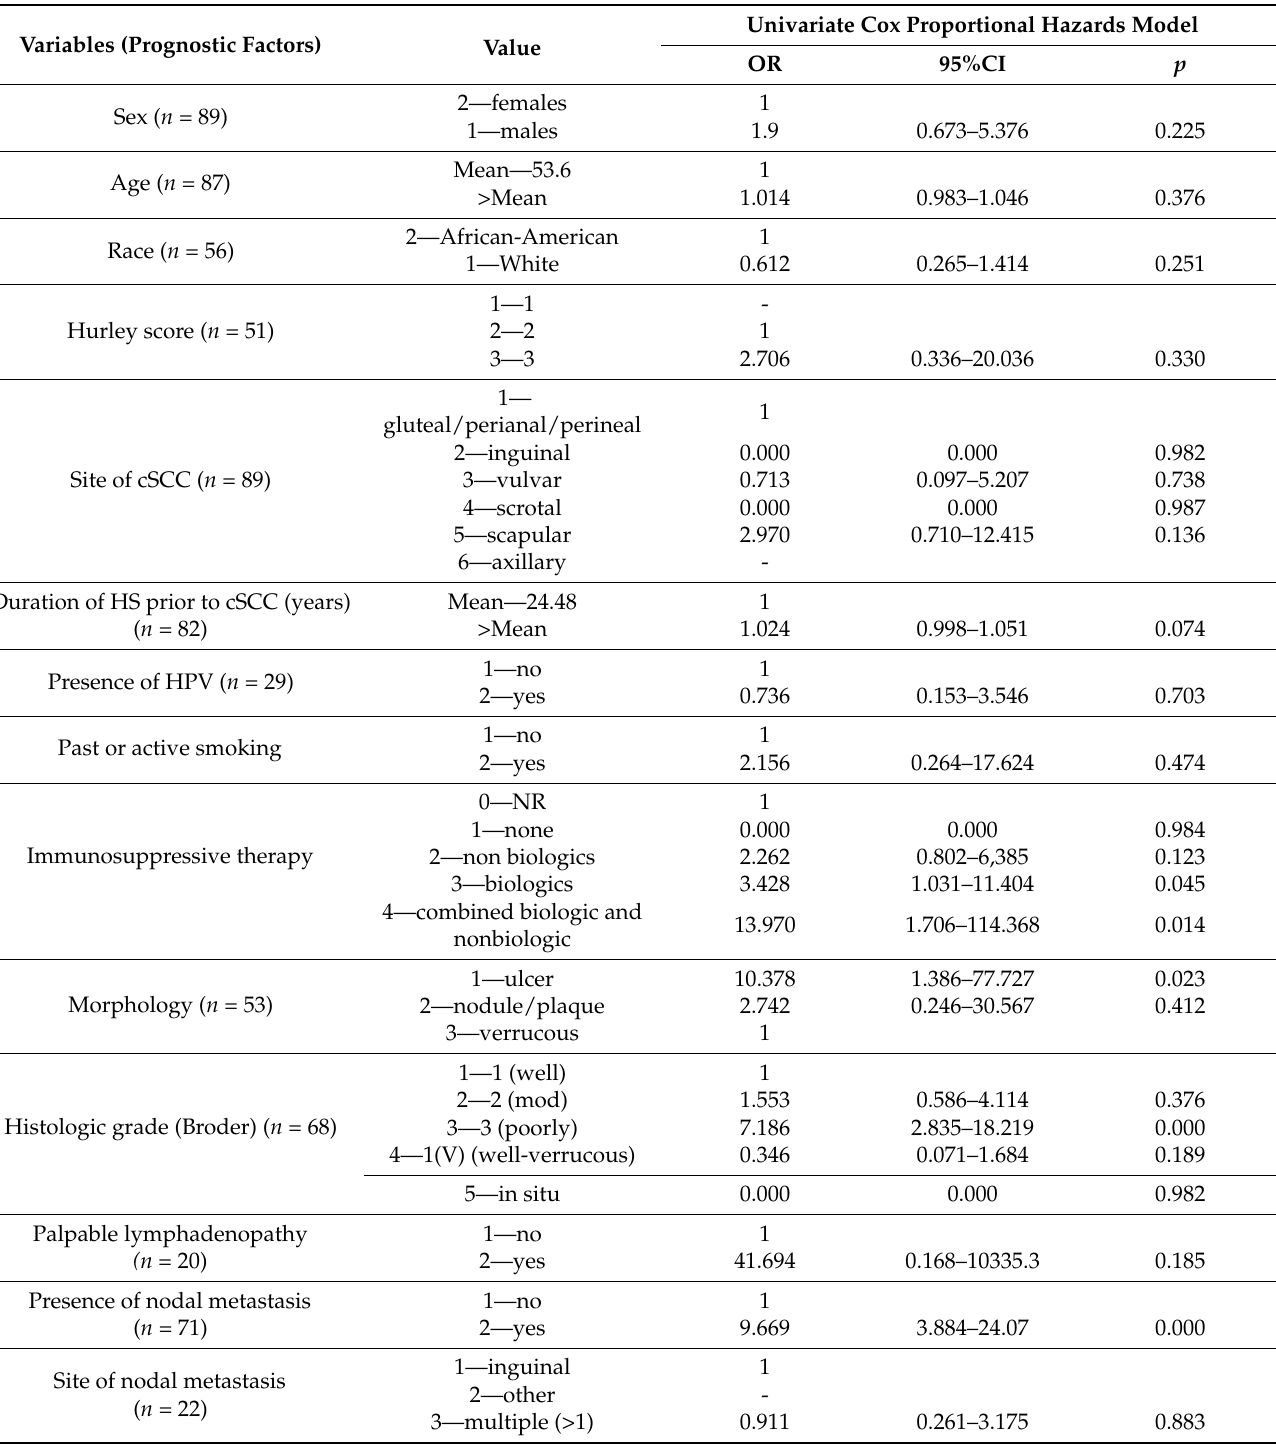
Table 2. Univariate Cox Proportional Hazards